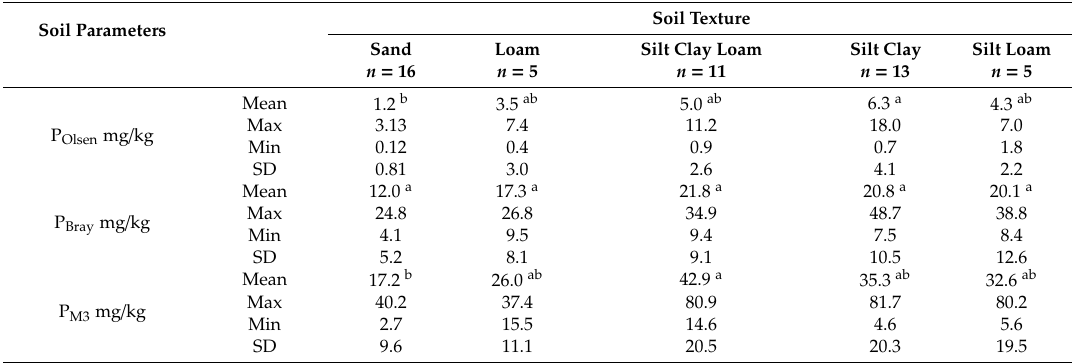
Table 2. The mean and standard deviation values for available phosphorus concentrations in the di ff erent soil textures